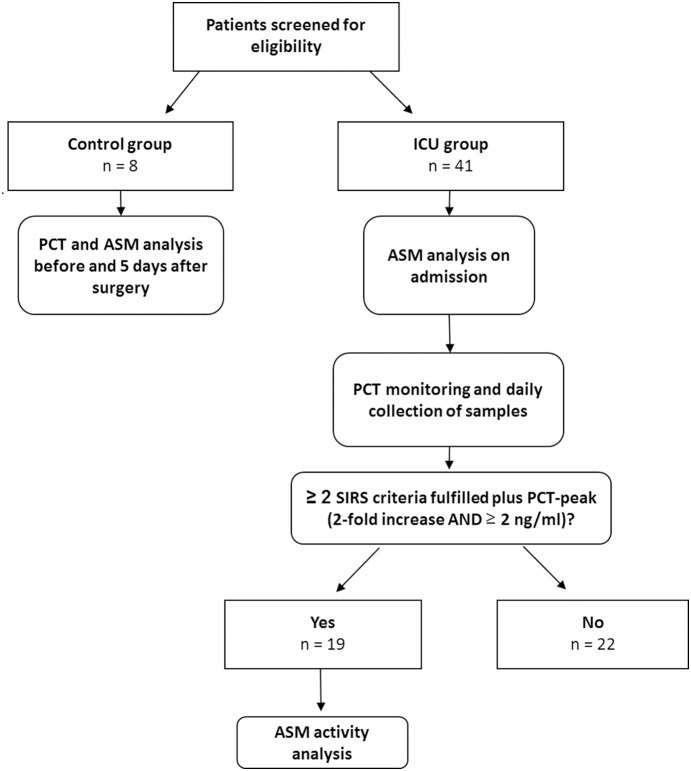
Study flow chart.